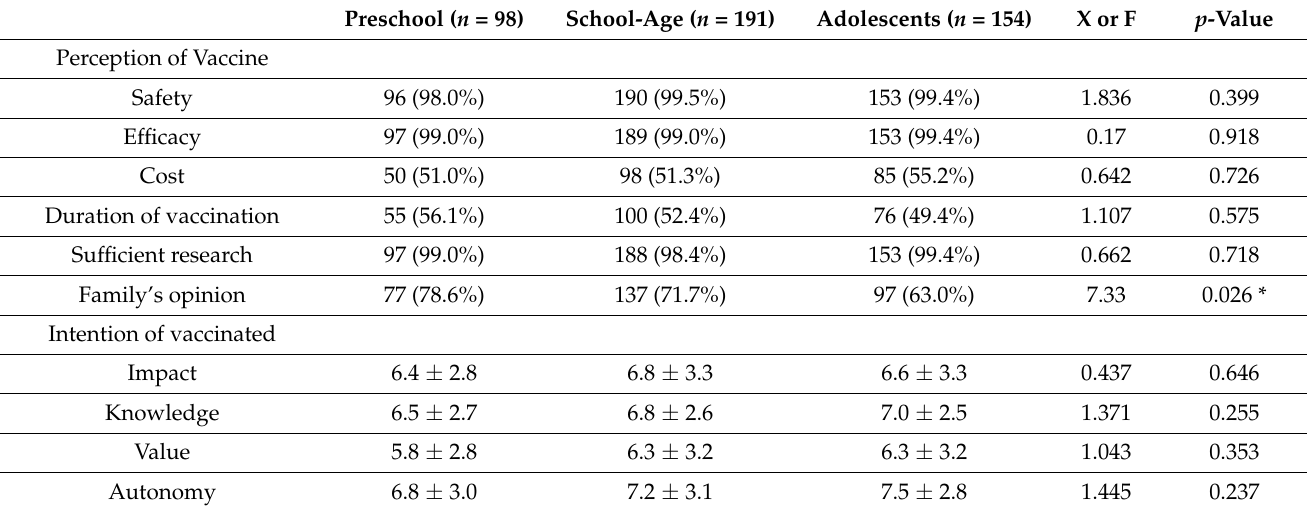
Table 3. The perception, and intention of COVID-19 vaccination among the caregivers of preschool, school-aged and adolescents individuals.